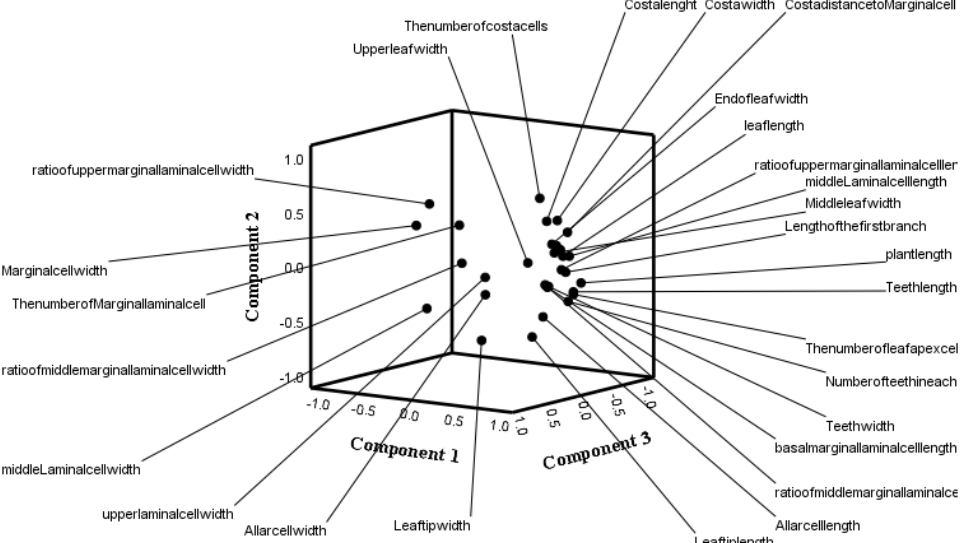
Fig. 5. The component plot in rotated space for the 28 examined characters.